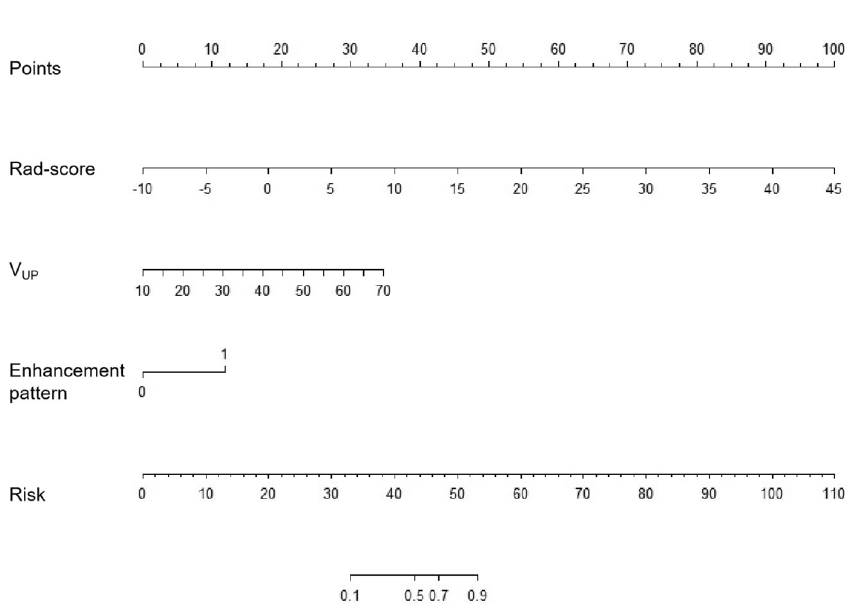
Figure 2. Convention-radiomics nomogram in differentiating fp-AML from ccRCC. The nomogram was constructed based on the whole cohort of 139